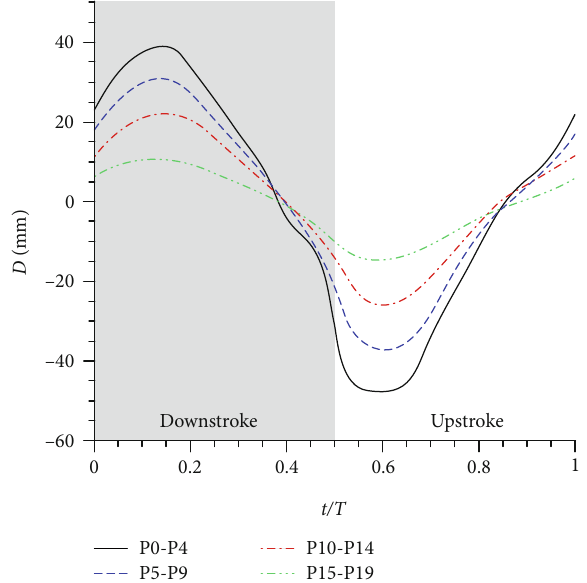
Figure 9: Deformation of points 0, 5, 10, and 15 on the trailing edge.